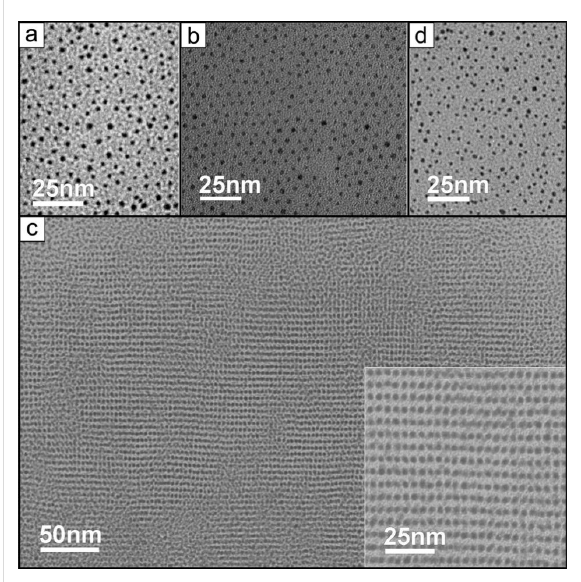
In another investigation into ligands of this type [94], although no mention was made of their liquid-crystalline properties, it was shown that NPs coated with triphenylenes 23 5,4 , 23 5,8 and 23 5,12 (Figure 25) were able to self-assemble into beautiful 2-D structures with hexagonal, squarelike and stripelike arrange- ments as a function of both the length of the tethering group and the solvent polarity (Figure 26). These results bode well for the use of these discotic materials in NP self-organisation, and it appears only a matter of time before LC phases are observed for discrete hybrids of this type.